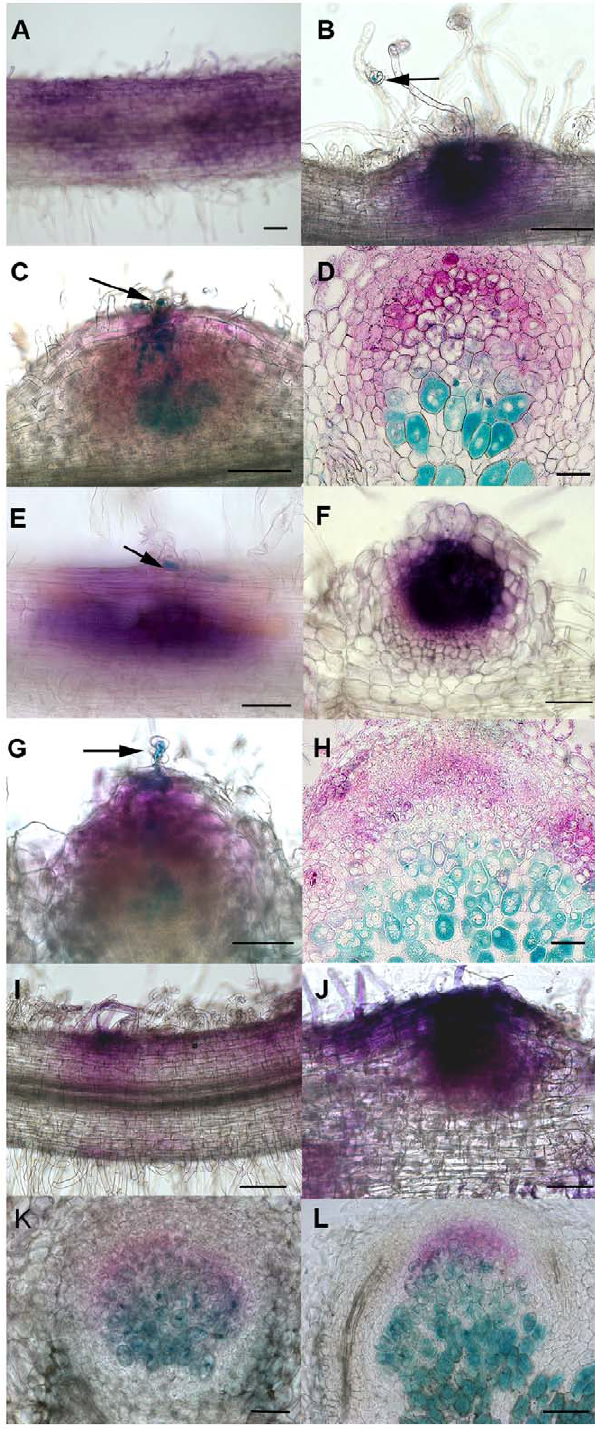
Figure 4. LysM swap constructs reveal different NFP LysM domain requirements for infection. nfp pMtENOD11:GUS plants were transformed with pNFP:SYM10-NFP (A, B), pNFP:NFP-NFP (C, D), LysM1 swap (E, F), LysM2 swap (G, H), LysM3 swap (I, J) or pNFP:SYM10- P154L-NFP (K, L). pMtENOD11:GUS activity (magenta) and rhizobial infection (revealed by lacZ activity, in blue) are shown in roots and nodule sections at 7 dpi (A, C, E, G, I, K) and 21 dpi (B, D, F, H, J, L) with wild type S. meliloti . Micro-colonies in curled root hairs are indicated by arrows in B, C, E, G. Bars=100 m m. D and H are microtome 5 m m-thick sections and F, J, K, L 70 m m-thick vibratome sections.